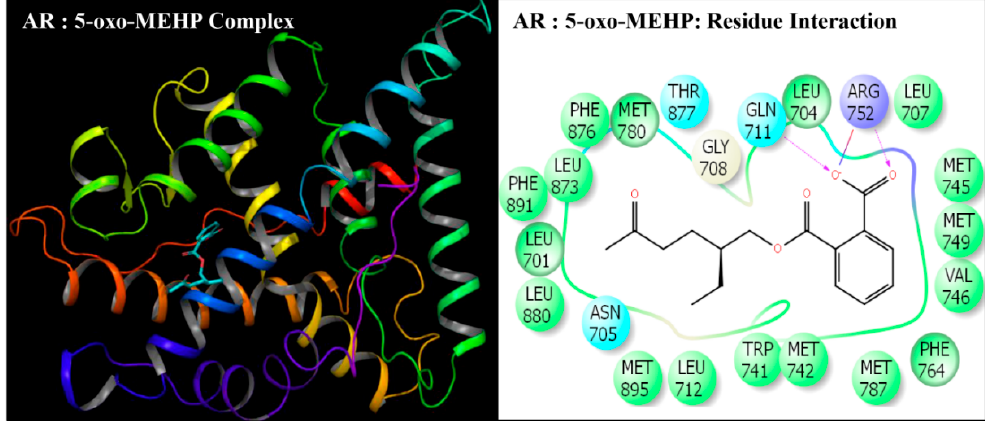
Figure 5. Ribbon diagram representing the docking pose of human androgen receptor (AR) with mono-(2-ethyl-5-oxohexyl)phthalate (5-oxo-MEHP) (left panel). The interactions of ligand (5-ox- MEHP) with amino-acid residues in the binding pocket of AR (right panel).